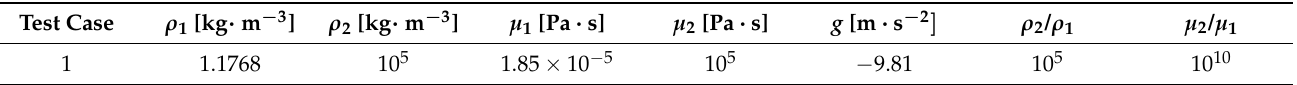
Table 1. Physical parameters describing the test cases. Here, ρ 2 and µ 2 refers to the fluid density and viscosity respectivly inside the droplet, ρ 1 and µ 1 ,refers to the density and viscosity of the surrounding fluid respectivly and g is the gravity. Test